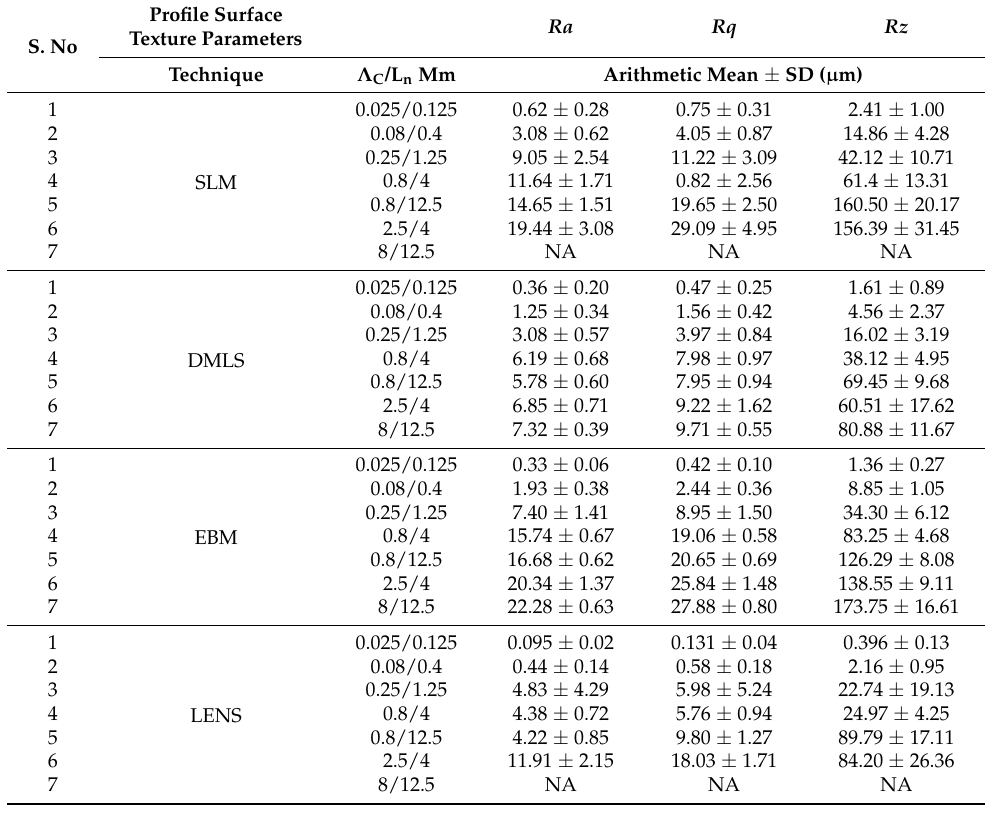
Table 4. Profile surface texture results for various cut-off wavelengths and evaluation